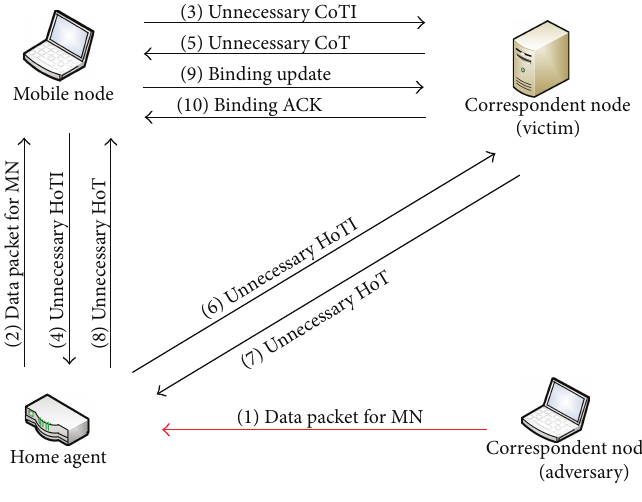
Figure 12: Amplification attack on RR-RO.